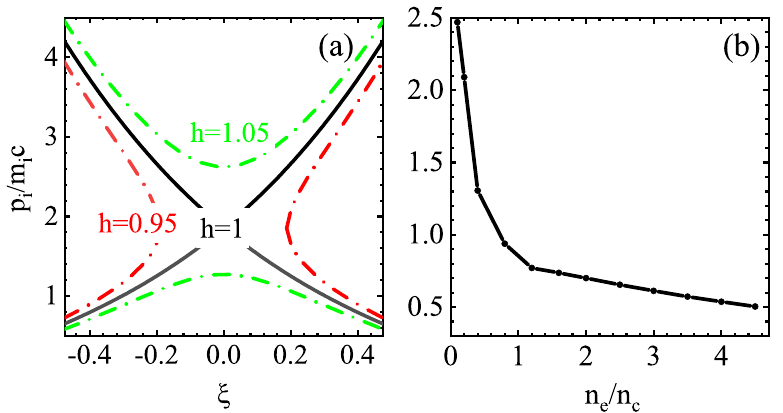
Figure 1. ( a ) The accelerating region of the ions in the ξ − p (cid:48) n e = 2 n c . The boundary of the accelerating region is defined by H ( ξ , p (cid:48) an ion will be accelerated (red dashed lines) by the electric field if H ( ξ , p (cid:48) minimum momentum p i / m i c as functions of the background density n e , obtained by Equation (2). The laser normalized amplitude is taken as a 0 =